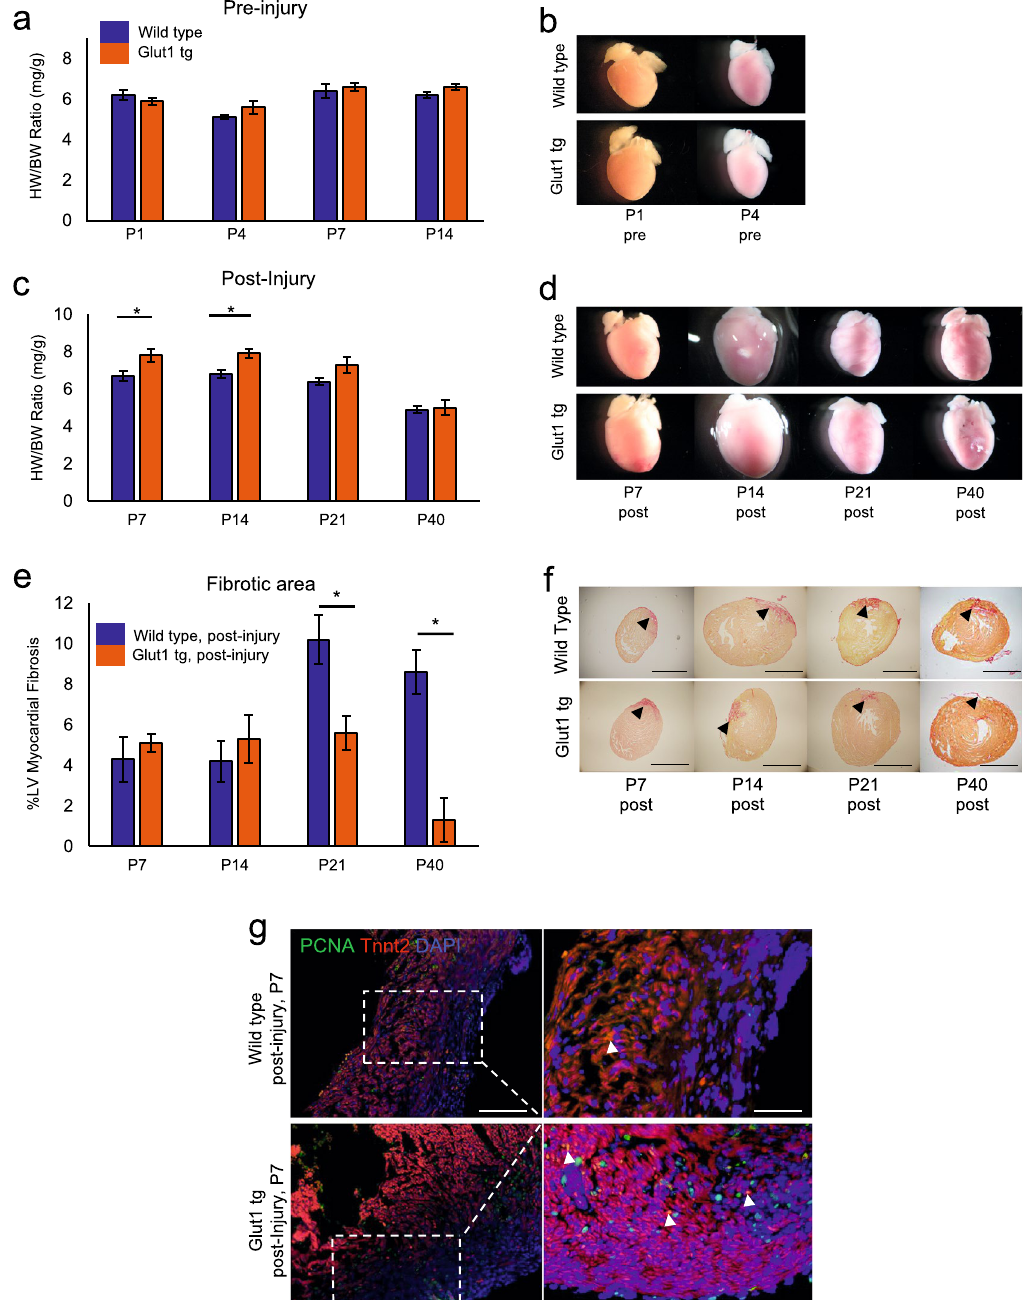
Figure 1. Increase in intracellular glucose promotes cardiac regeneration in Glut1 transgenic heart. ( a ) Heart weight-body weight (HW/BW) ratio of Wild type and Glut1 transgenic (Glut1 tg) mice without injury. n = 3–7 for each group, p = n.s. ( b ) Representative images of hearts. ( c ) Heart weight-body weight (HW/BW) ratio of Wild type and Glut1 transgenic mouse post-injury. The hearts were cryoinjured at P1 and examined at P7, 14, 21 and 40. Note that the HW/BW is higher in Glut1 transgenic hearts at P7 and 14. n = 4–9 for each group, * p < 0.05. ( d ) Images of representative hearts post-injury. Note the ballooning of the heart at P14 in both wild type and Glut1 transgenic hearts. ( e ) %Fibrotic area measured by Image J capture of Picrosirius red stainings of the hearts. Hearts were cryoinjured at P1 and examined at P7, 14, 21 and 40. n = 5–8 for each group, * p < 0.05. ( f ) Representative images of Picrosirius red staining of wild type and Glut1 transgenic hearts. Arrowheads indicate fibrotic area. Scale bar = 200 µm. ( g ) PCNA staining of the sections from wild type and Glut1 transgenic hearts 7 days post-injury. Sections were stained with a cardiac marker (Tnnt2; Red), proliferation marker (PCNA; Green) and a nuclear marker (DAPI; Blue). Note that PCNA staining is more abundant in Glut1 transgenic heart. Arrowheads indicate PCNA positive cardiomyocytes. Scale bar = 50 µm and 20 µm